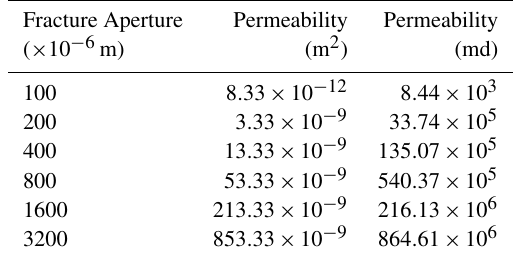
Table 2. Fracture aperture and permeability values. Fracture